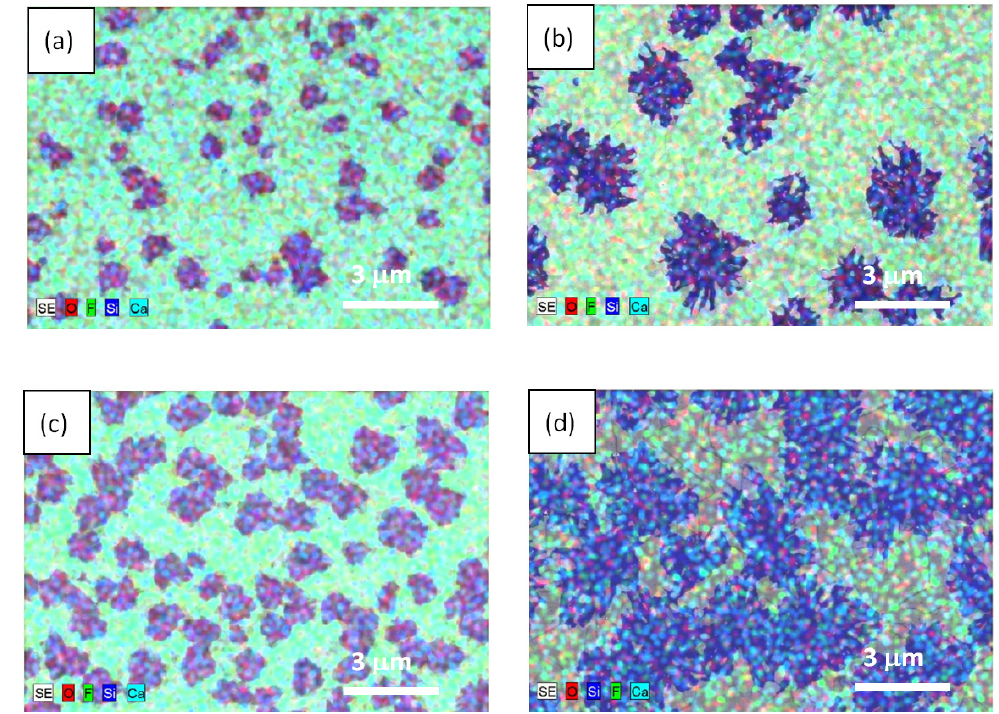
Figure 3. ( a )—Energy-dispersive X-ray spectroscopy data obtained for the structures with different thicknesses of epitaxial films. Left column—29 nm thick film; right column—53 nm thick film. Panels ( a , b ) correspond to a 2 min exposure time. Panels ( c , d ) (correspond to a 4 min exposure time.